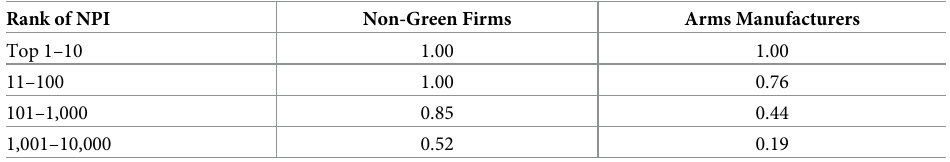
Table 1. Influential ultimate owners connected to non-ESG